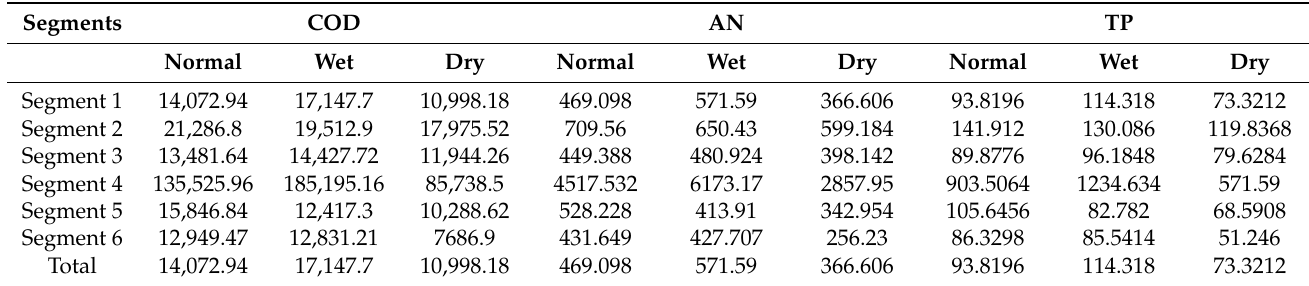
Table 13. Water capacity results